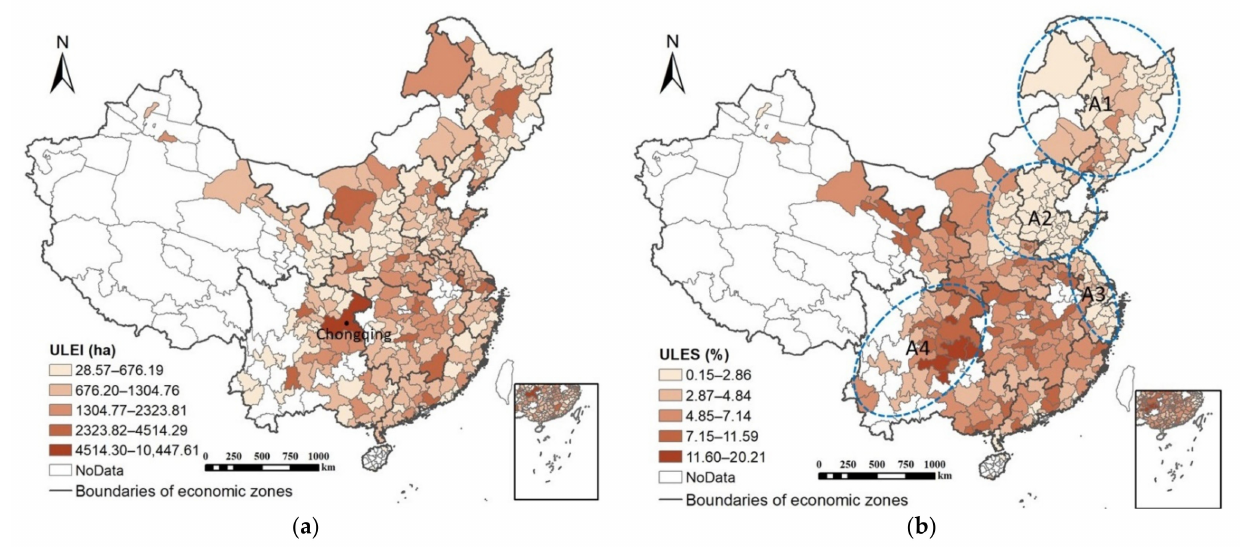
Figure 4. Change in urban land from 2009 to 2016. ( a ) ULEI; ( b )